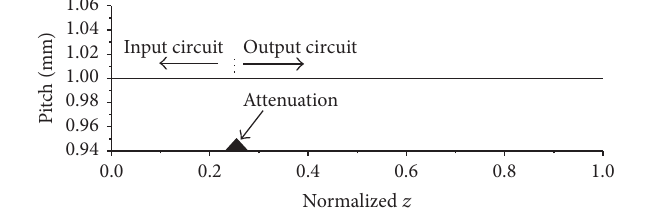
0.0 Figure 9: Pitch and attenuation profile of the FWG TWT (black and white).